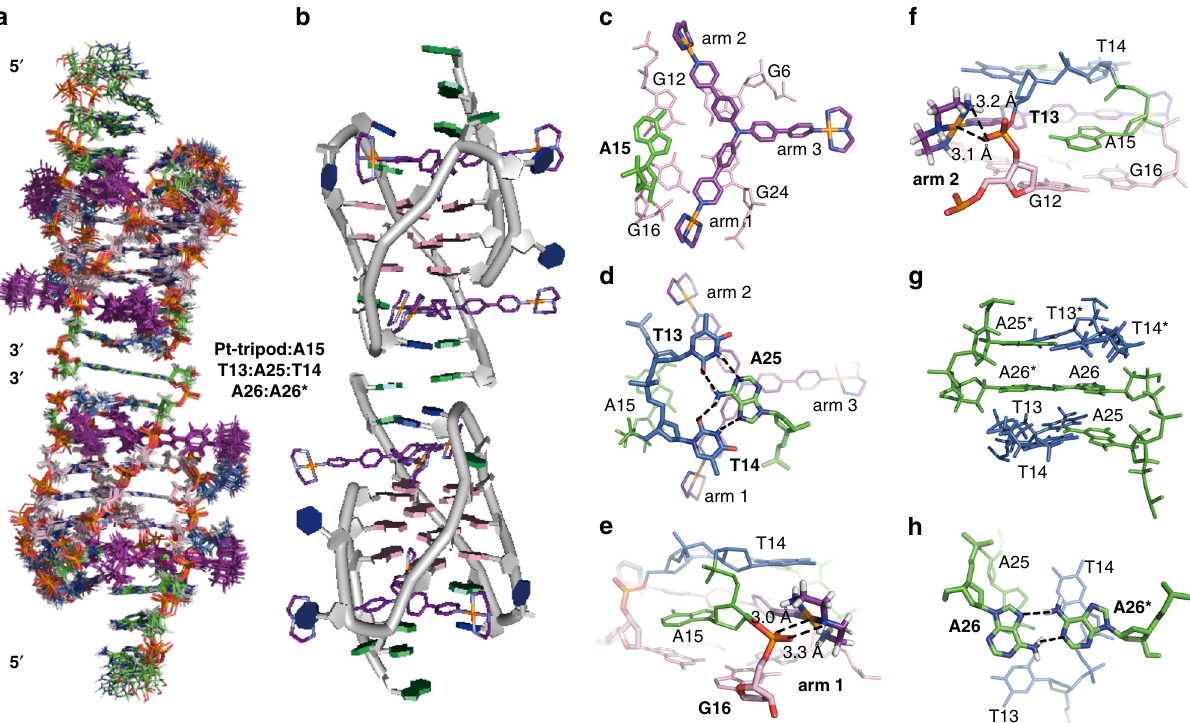
Fig. 6 Solution structure of the unique dimeric 4:2 Pt-tripod – Tel26 complex (PDB code: 5Z8F). a The ensemble of the superimposed 15 NMR restraints- re fi ned structures of the dimeric 4:2 complex. b A representative structure of the dimeric 4:2 complex. c , d Two different views of the Pt-tripod-induced binding pockets at the 3 ʹ -end with residues labeled. e , f Electrostatic interactions between the platinum units of the fi rst and second Pt-tripod arms with the negative backbones of Tel26 at the 3 ʹ -end. The distance between the NH of the fi rst platinum unit and the oxygen of the G16 backbone (N-O) is 3.3 Å; the distance between the Pt of the fi rst platinum unit and the oxygen of the G16 backbone (Pt-O) is 3.0 Å ( e ). The distance between the NH 2 of the second platinum unit and the oxygen of the T13 backbone (N-O) is 3.2 Å; the distance between the Pt of the second platinum unit and the oxygen of the T13 backbone (Pt-O) is 3.1 Å ( f ). g , h Two different views of the 3 ʹ – 3 ʹ interface of the dimeric complex structure with residues labeled. Hydrogen bonding between T13:A25, T14:A25, and A26:A26* are labeled. The Pt-tripod molecules are colored in purple. Guanines are colored in pink. Adenines are colored in green. Thymines are colored in blue. Residues from the other subunits are labeled with